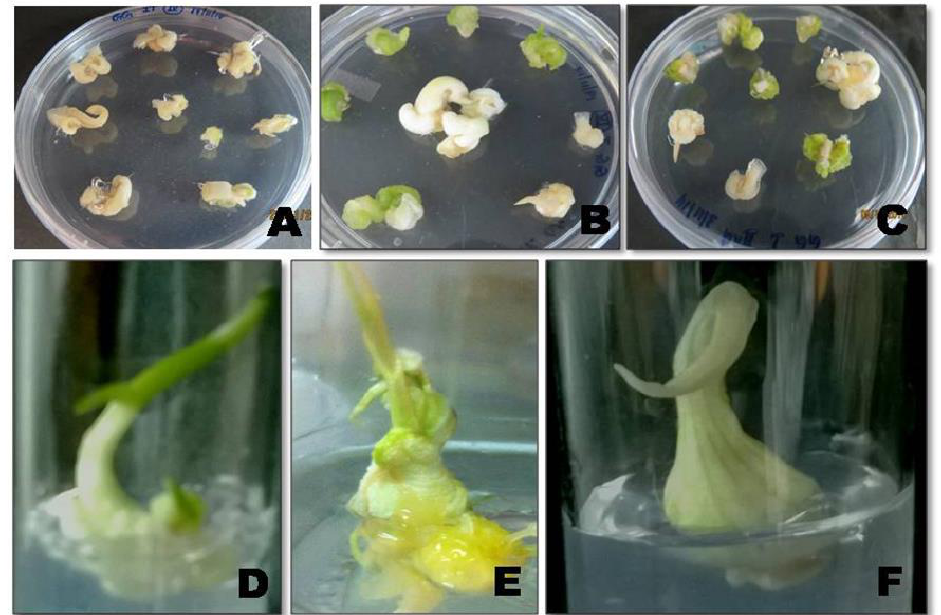
Figure 2. Biolistic/gene gun-mediated transformation in onion calli. ( A ) Wild type calli on selection media; ( B , C ) Transformed calli on selection media (MS+B5 + 1.0 mg L −1 picloram + 20 mg L −1 glufosinate-ammonium; ( C ) Transformed calli after four rounds of selection; ( D , E ) Transformed callus on regeneration medium (MS + 0.5 mg L −1 KIN + 0.5 mg L −1 BAP + 0.1 mg L −1 NAA + 20 mg L −1 glufosinate-ammonium); ( F ) Transformed callus on bulb initiation medium (MS+B5 + 2.0 mg L −1 BAP).